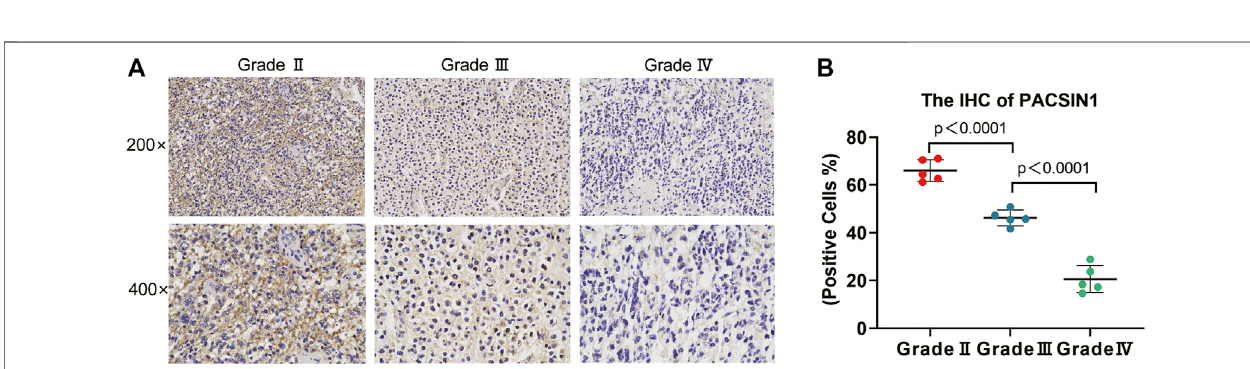
( Figure 3B,C,E,F ). All the above results suggested that PACSIN1 upregulated in IDH1-mutant gliomas and downregulated in 1P/19q non-codel gliomas.